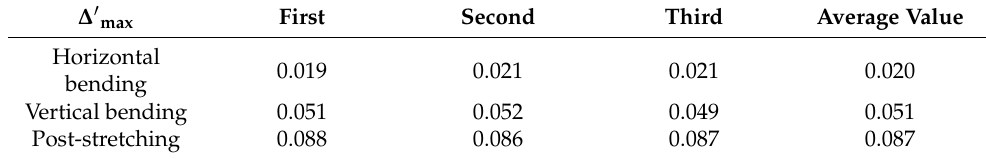
Table 8. The thickness measurement results of the inner web of experiment N3 µ s 1 δ pre 2 δ po 2. ∆ (cid:48)